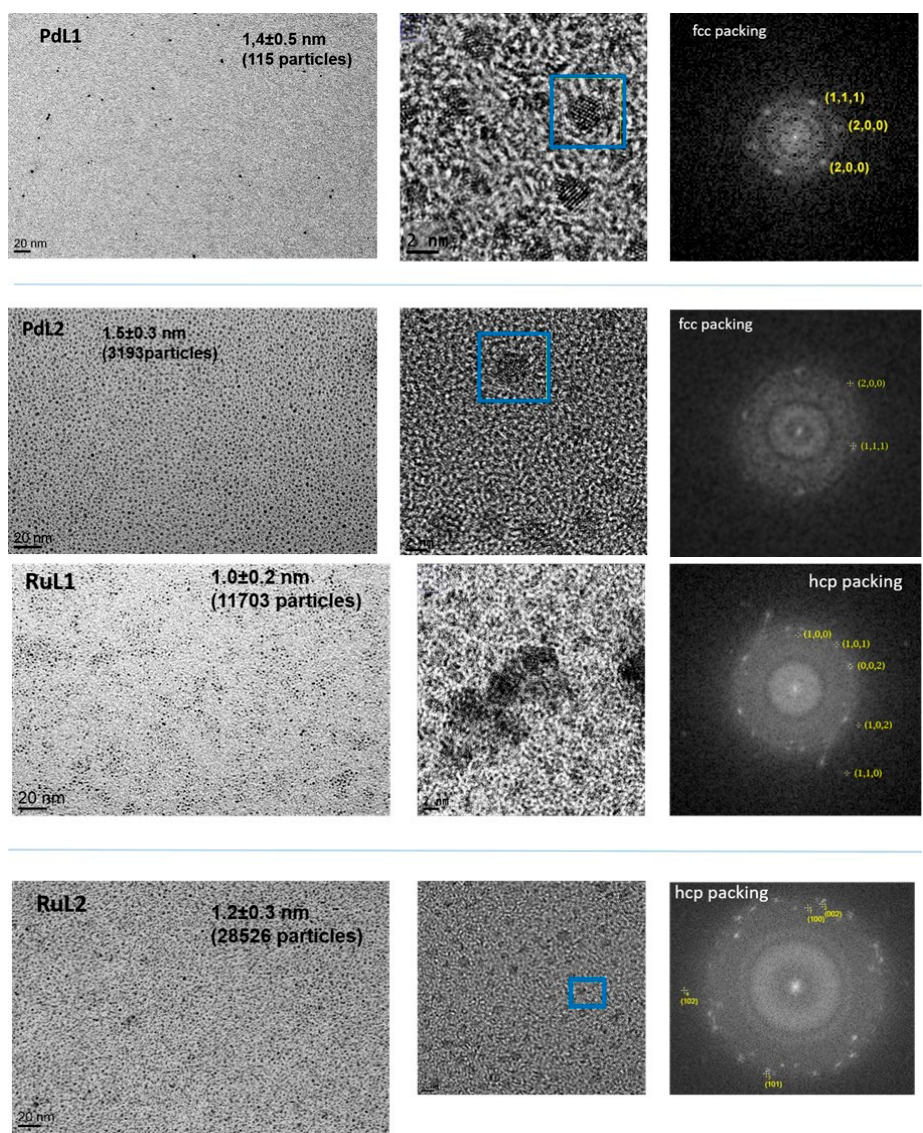
Figure 4. TEM ( left ), HR ‐ TEM ( middle ) and electronic diffraction ( right ) images of PdNPs and RuNPs stabilised by L1 and L2 .